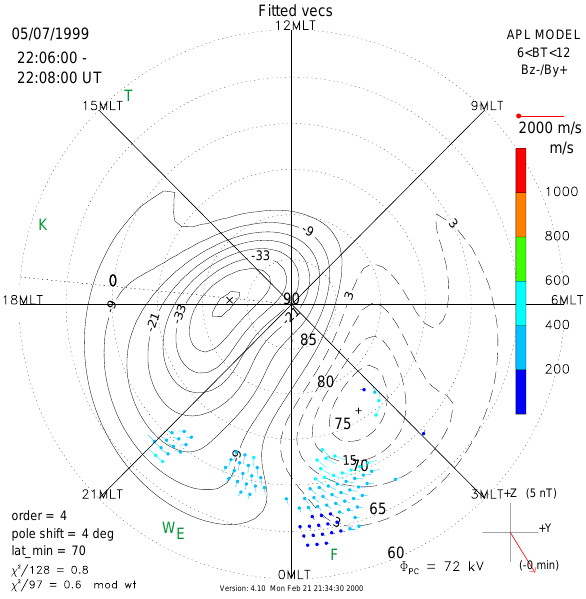
Fig. 8. Instantaneous nightside convection pattern derived from Su- perDARN observations between 22:06:00 and 22:08:00 UT on 7 May 1999. Note the good agreement with the convection pattern derived from Astrid-2, STARE and the ground-based magnetome- ter